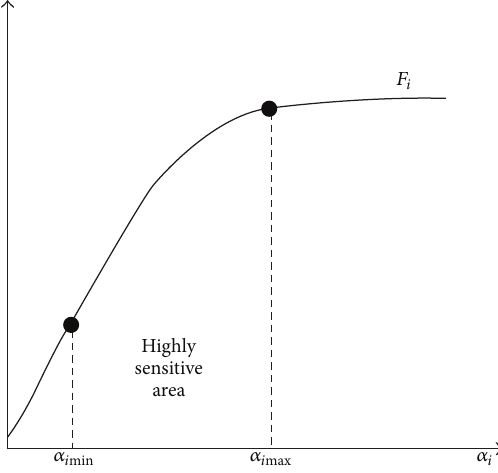
Figure 3: Changes of system characteristic 𝐹 with 𝛼 𝑖 .